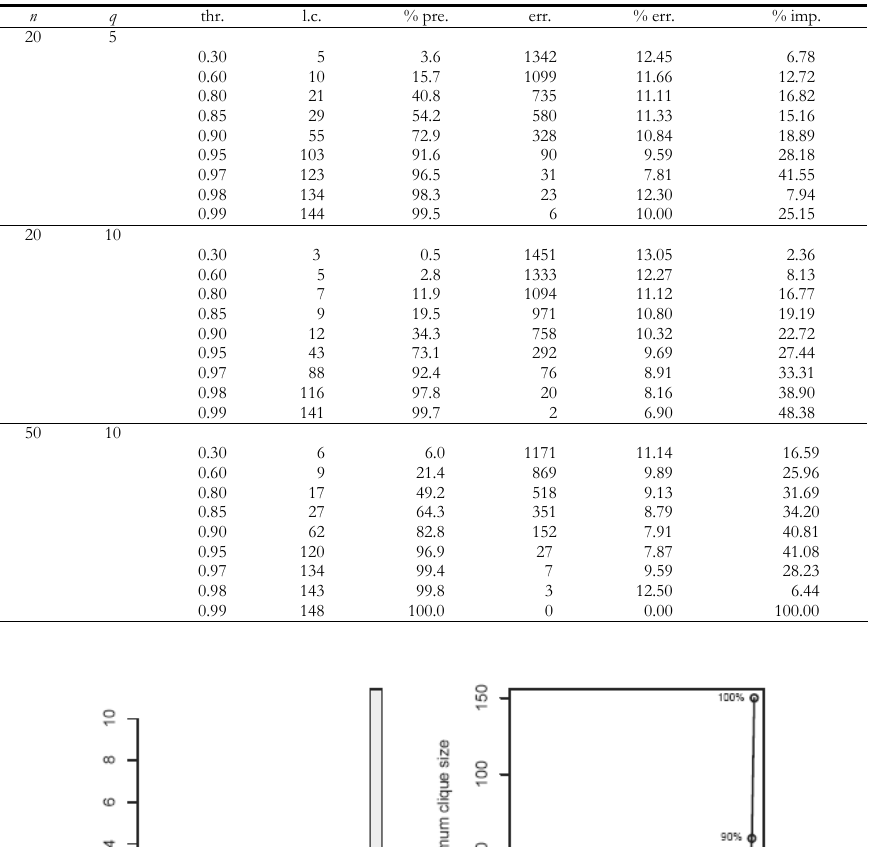
Graph G 2 = (V,E 2 ). Numerical description of the output of the qp-procedure applied for different values of n and q. See table 1 for a description of columns